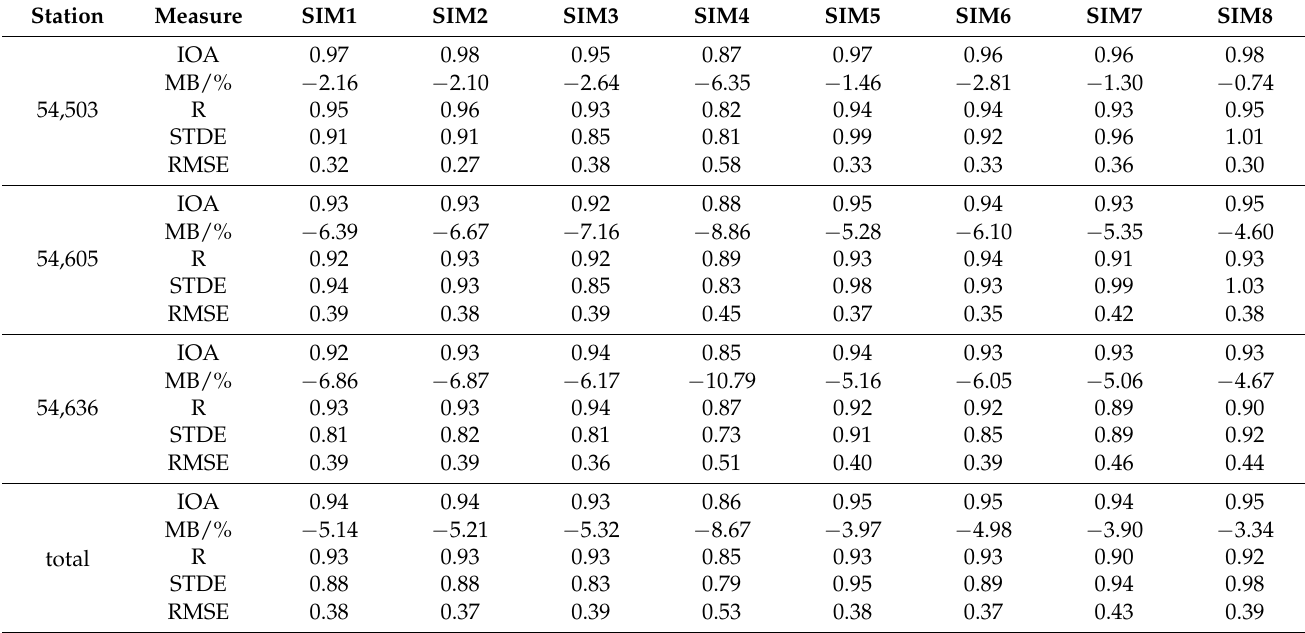
Table 3. The 2-m relative humidity in the Xiongan New Area from observations and eight combined scheme